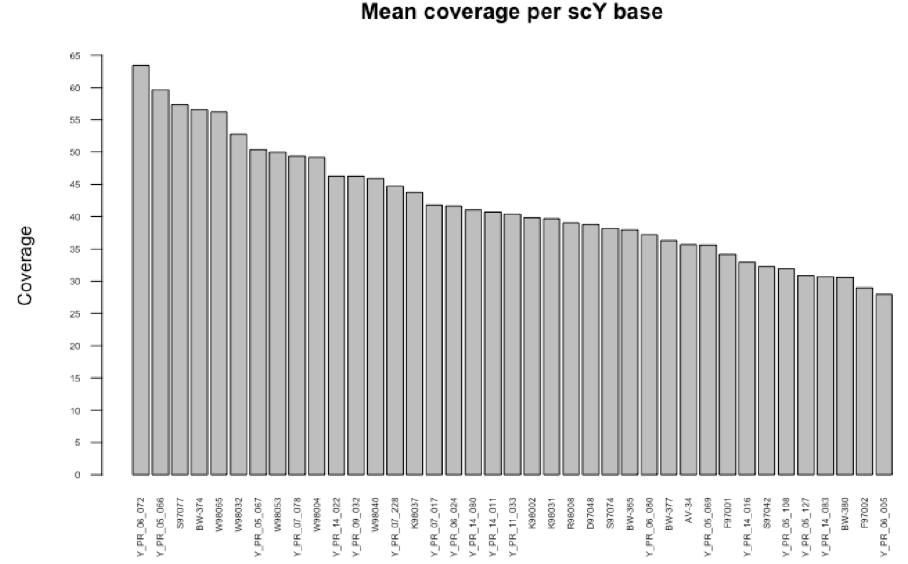
Figure A1. Target-enriched sequencing depth.